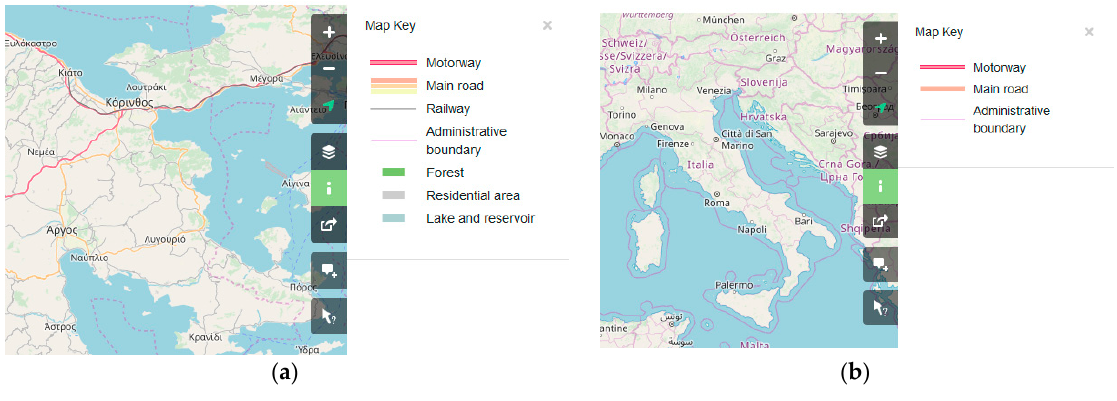
Figure 1. OpenStreetMap (OSM) maps and map key ( a,b ).